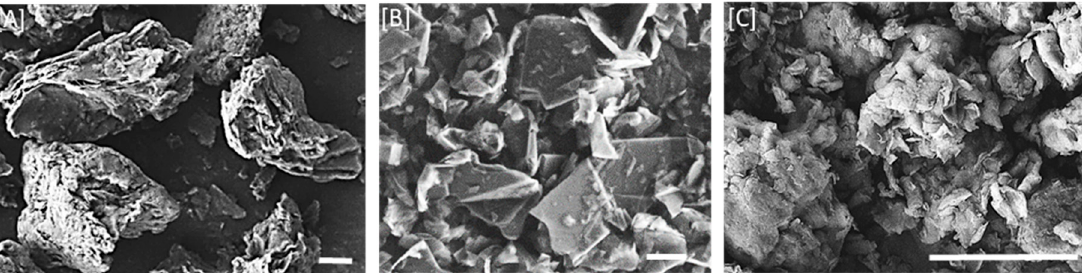
Figure 1. SEM micrographs of ( A ) graphite powder Alfa Aesar (GPA) × 430, ( B ) graphite BTC (GPB) × 1000, and ( C ) clay × 5000; scale bar = 10 µm.